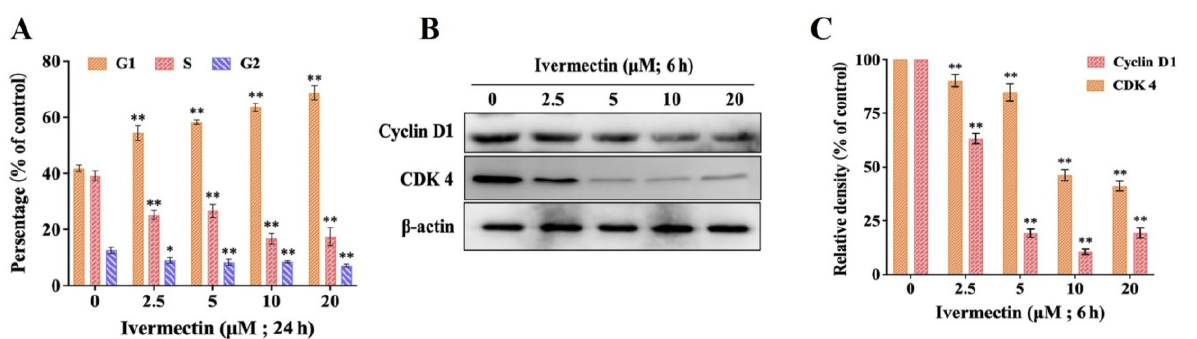
Figure 2. IVM induces cell cycle arrest in RAW264.7 cells. ( A ) Percentage of cells in G1-, G2-, and S-phases after IVM treatment of RAW264.7 cells for 24 h. ( B ) Cyclin D1 and CDK 4 expression in RAW264.7 cells treated with IVM for 6 h. ( C ) Densitometric analysis of the expression levels of cyclin D1 and CDK 4. Data were expressed as means ± SD (standard deviation) of three separate sets of independent experiments. * p < 0.05, ** p < 0.01, and indicate the significant differences from the